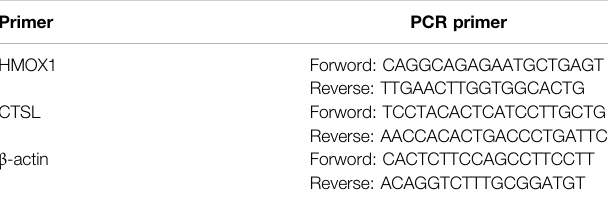
TABLE 1 | The primer sequences for PCR. Primer